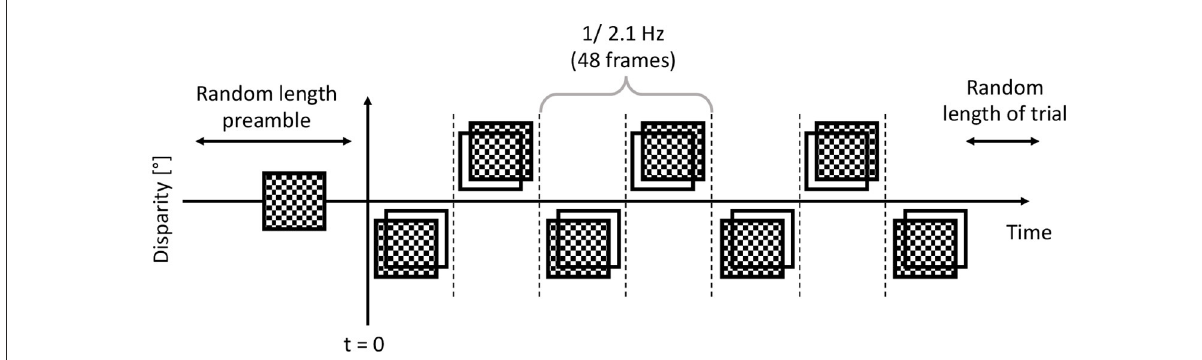
FIGURE4 After the participant started the trial, before t = 0 , the trial had zero disparity random dots displayed for 1...1.5 seconds. Then at t = 0 , the dots had their disparity applied, exactly in the same frequency and phase in each trial. This alternating depth plane was displayed for a further 5-6